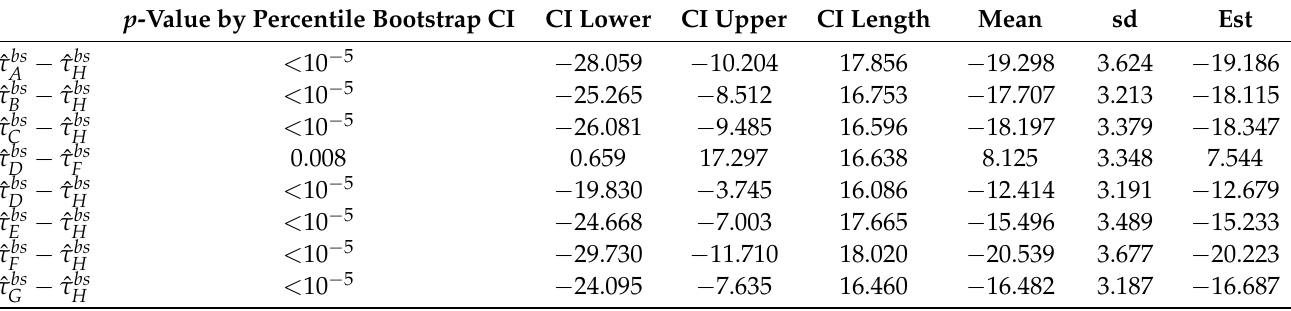
Table 2. Using residual(nonparametric) bootstrap methods: False coverage-statement rate (FCR)— Adjusted BH-Selected CIs for selected parameters indicated by the percentile bootstrap CI; All confidence intervals above show significance against H 0 : τ i = τ j